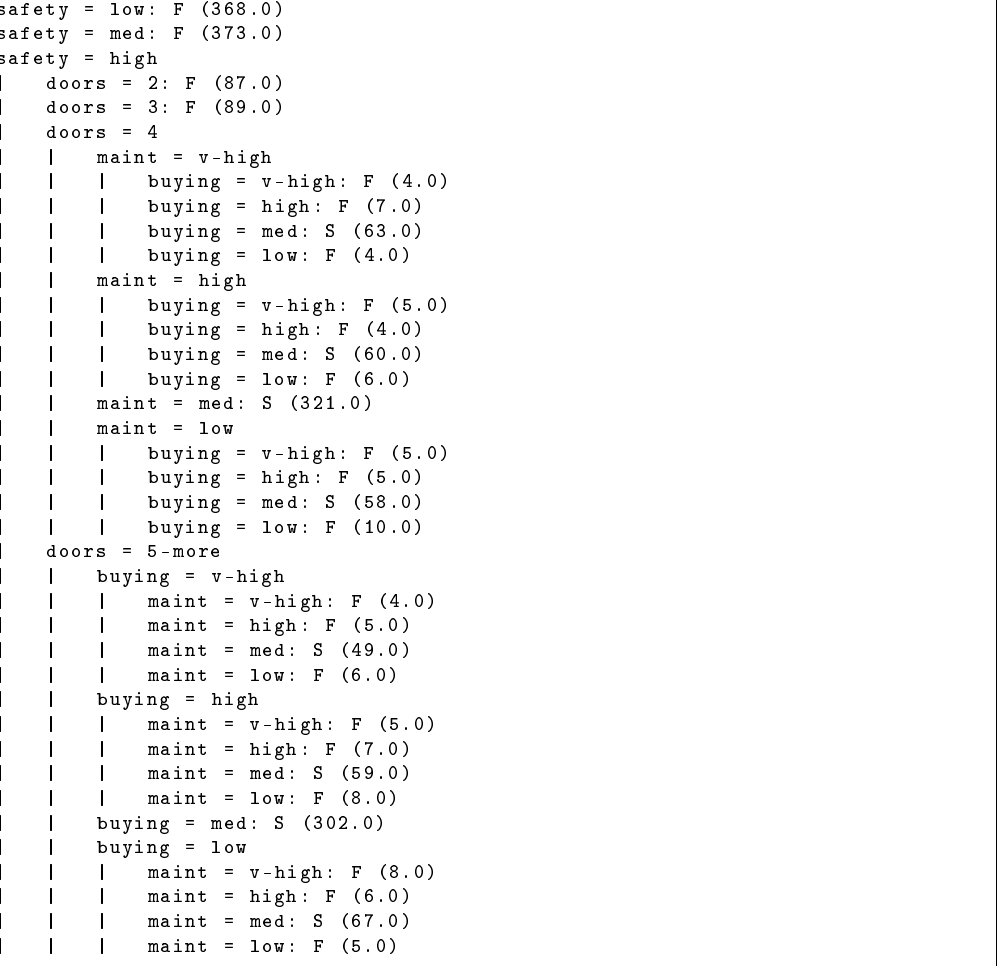
Figure 2. Hidden mental state model of the acceptable A constraint, obtained using a decision tree algorithm (J48) with a dataset gathering 2000 conversations, which follow the protocol defined in Figure 1. The notation “a = v : T/F” indicates that “if the term a has value v , the target predicate has a value of true or false”. Every leaf includes the number of instances classified under a certain branch in